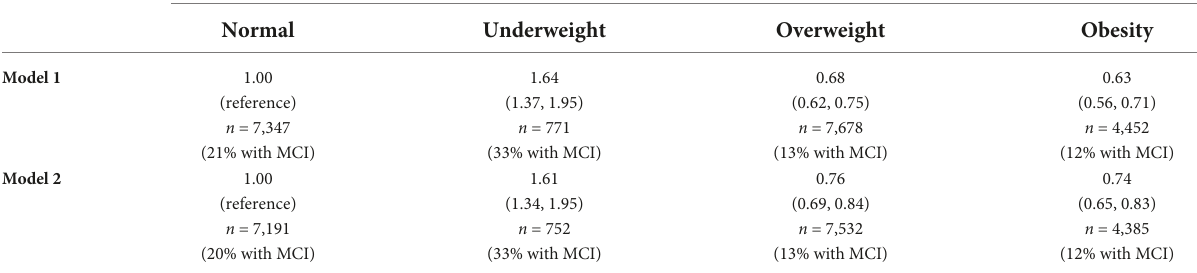
TABLE 2 Associations of body mass index with mild cognitive